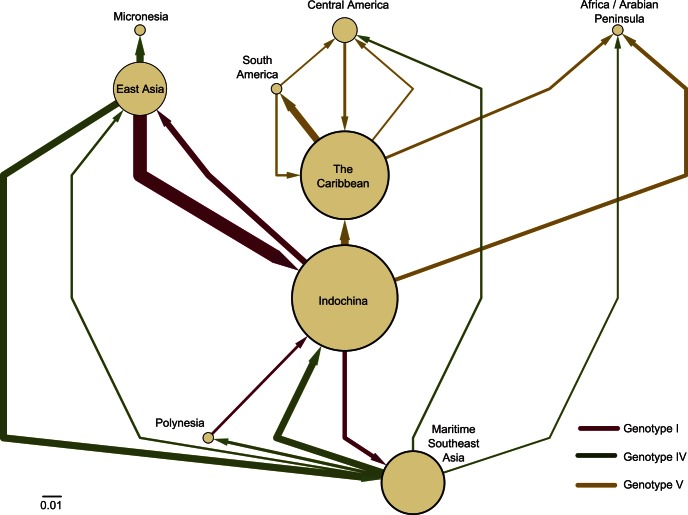
Network visualization of diffusion of DENV-1 genotypes.The analysis was done over major geographical areas and integrating migration rates among them as attributes. Thickness gauge at the bar scale for rates.